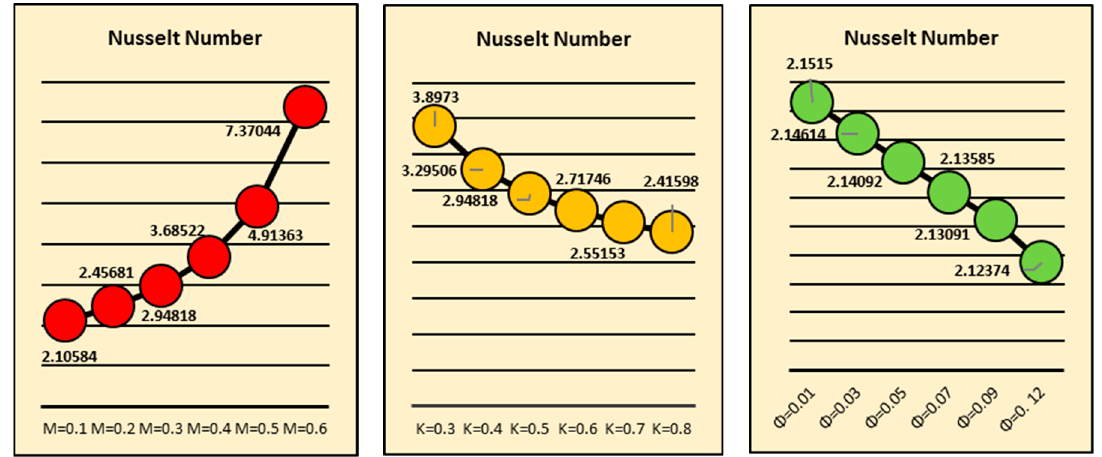
Figure 13. Effects of M , k and ϕ on the local Nusselt number.